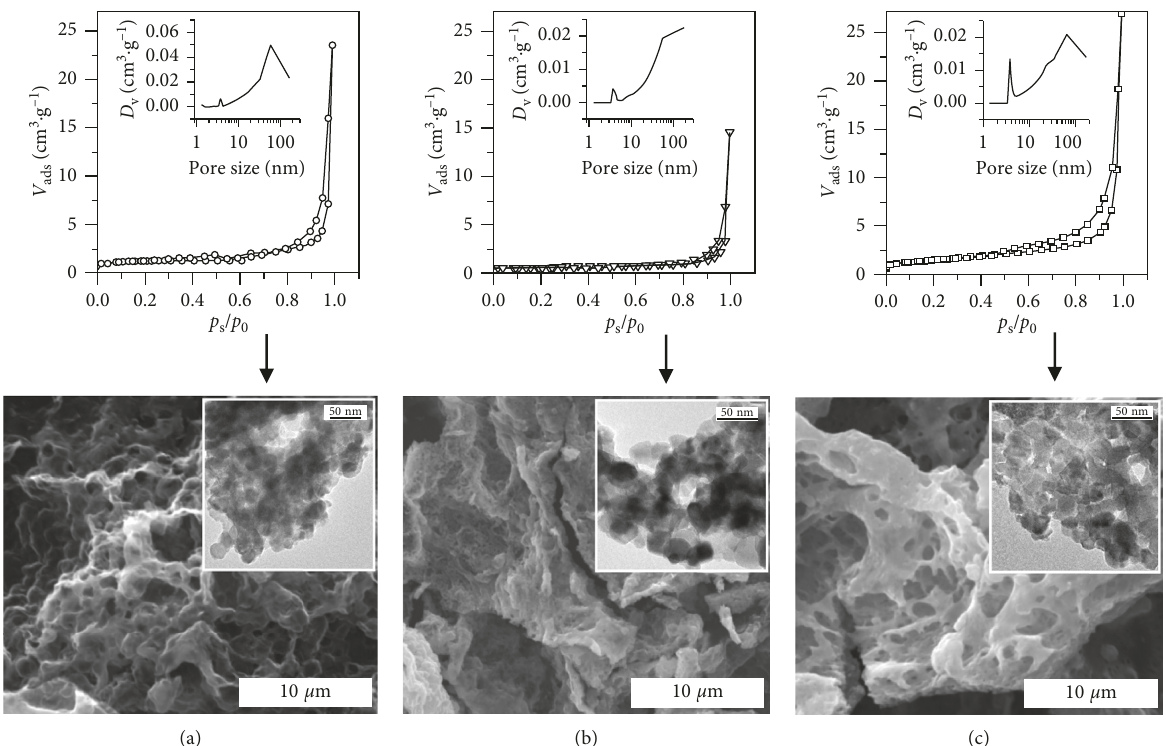
Figure 2: Adsorption and desorption isotherm of nitrogen for the samples: P1-C2O4 (a), P2-CO3 (b), and P3-OH (c). Inset: pore size distribution. SEM and TEM micrographs of the ferrite powders are given below the adsorption and desorption isotherms.